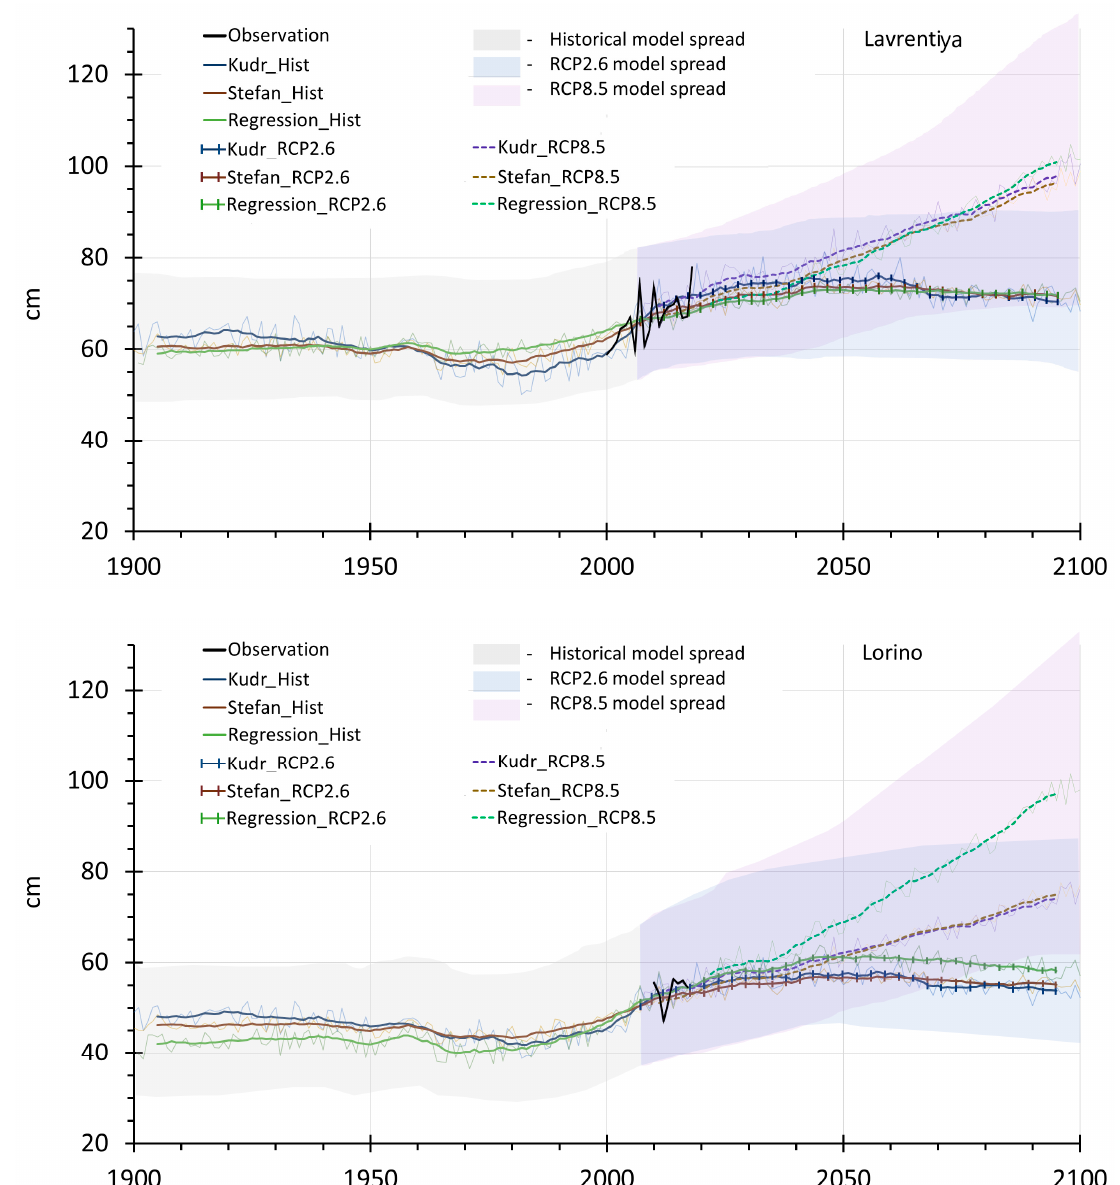
Figure 8. Historical and projected ALT dynamics for the Lavrentiya ( upper ) and Lorino ( lower ) CALM sites based on 3 models and RCP 2.6 and 8.5 climatic scenarios. The uncertainty bound (model spread) is calculated as described in Section 3.3.